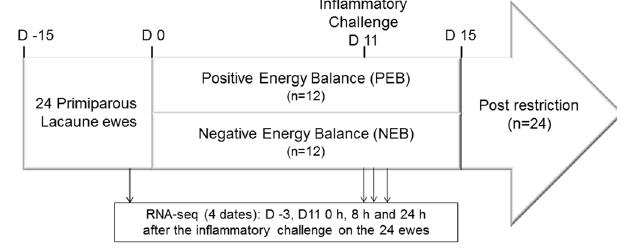
Figure 5. Experiment